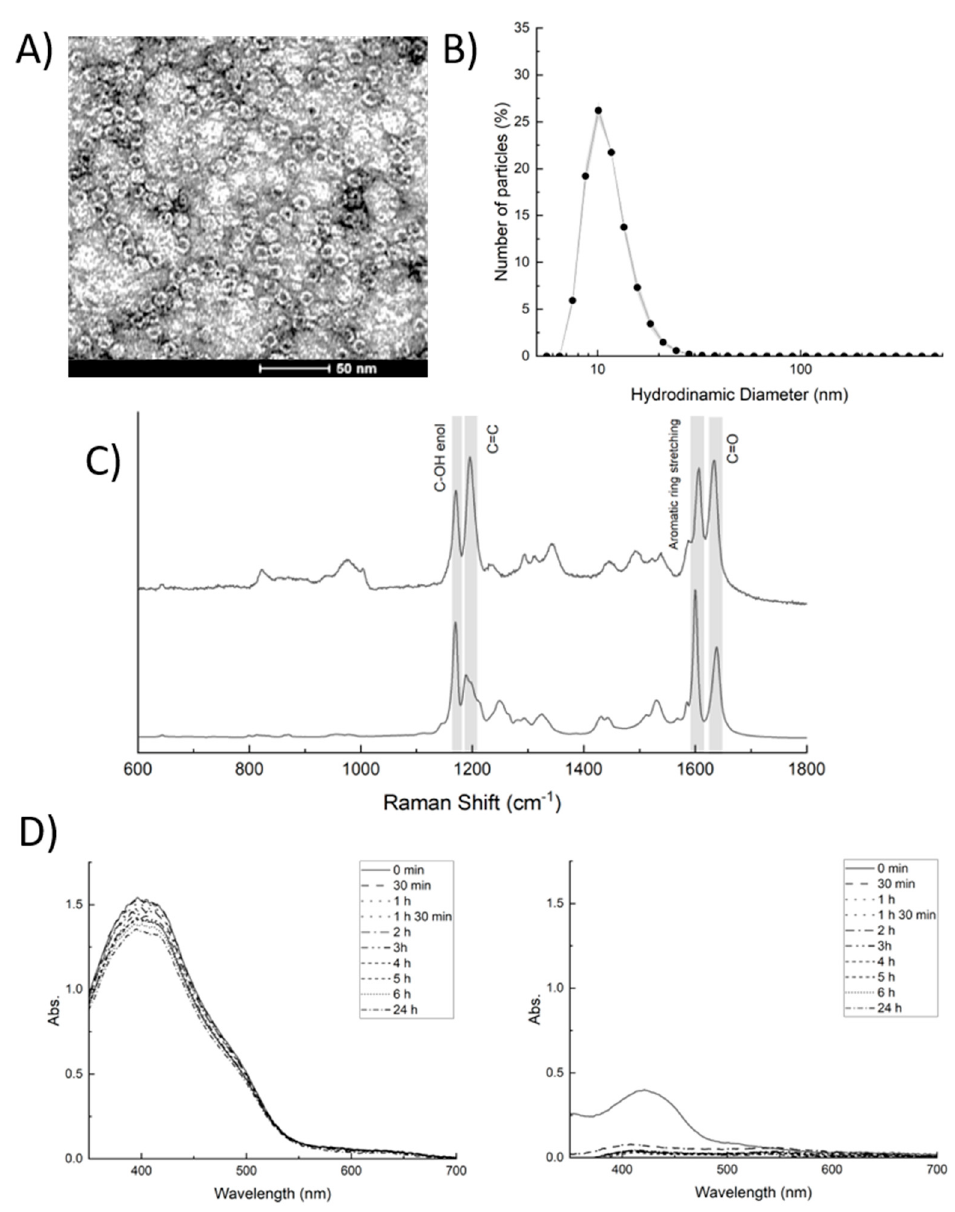
Figure 2. ( A ) TEM pictures of BDC-HFn nanoparticles. ( B ) DLS analysis of BDC-HFn nanoparticles. Data are presented as the mean of three independent acquisitions. ( C ) Raman spectra of BDC (top) and BDC-HFn (bottom). ( D ) UV–Vis spectra of BDC-HFn (left) and BDC (right) obtained at different time points between 0 min and 24 h.